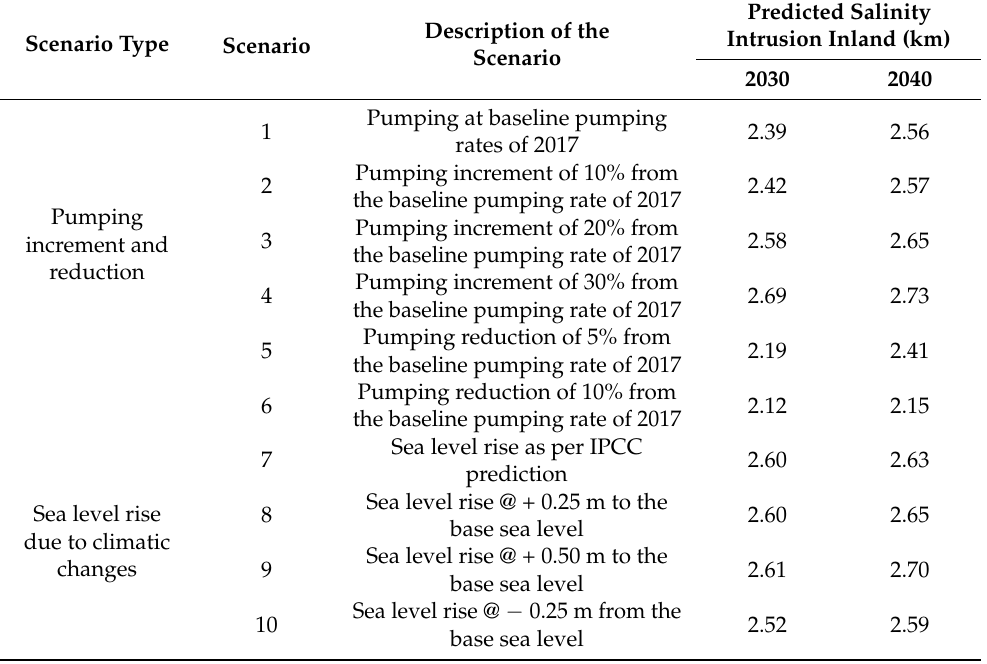
Table 5. Summary of the scenarios considering changes in the pumping rates and sea level